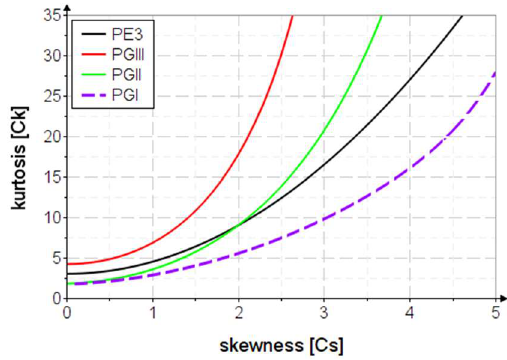
C C  Figure 7. The s k diagram for the analyzed distributions. Figure 7. The C s − C k diagram for the analyzed